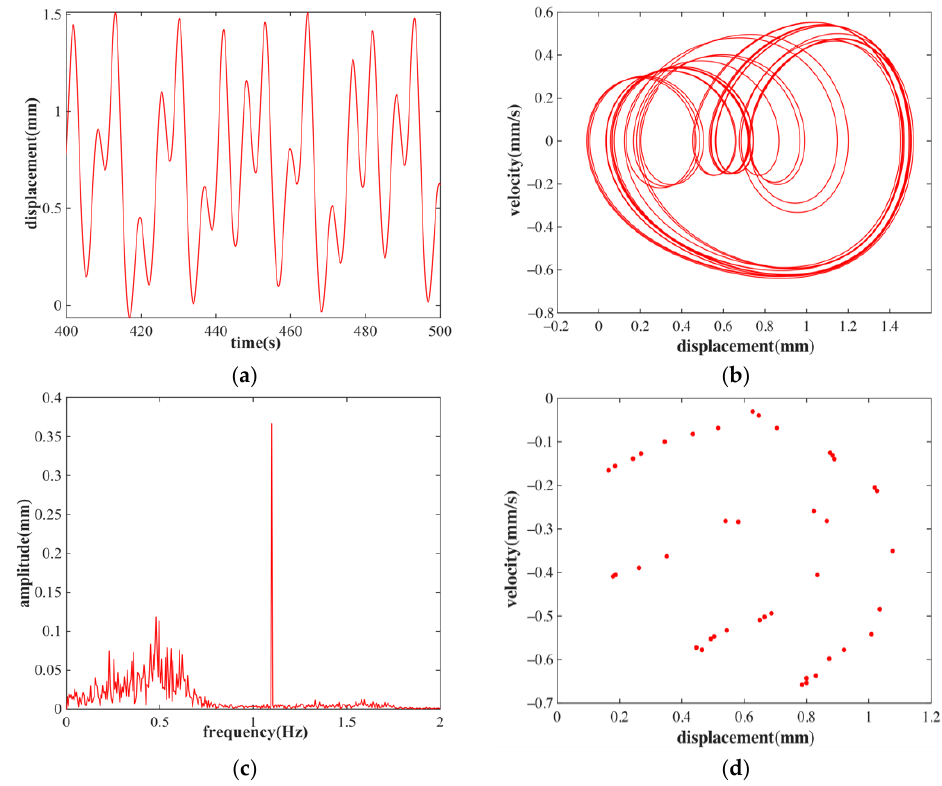
Figure 12. Nonlinear response of the GMA system at α = 0.41: ( a ) Time domain waveform diagram; ( b ) Phase trajectory curve; ( c ) Amplitude spectrum; ( d ) Poincaré diagram.